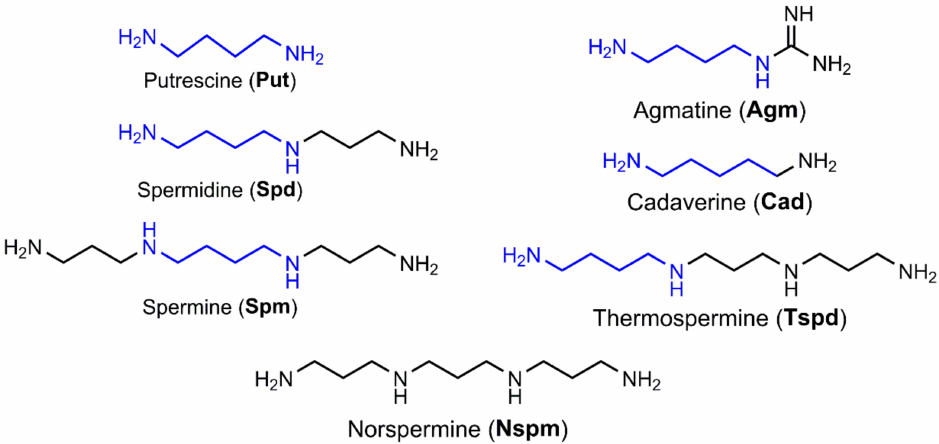
Figure 1. Structure of biogenic